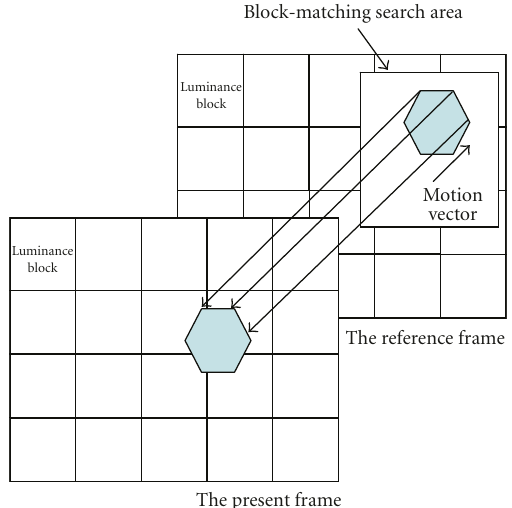
Figure 1: Block Matching Process, the two frames used to determine the motion vector of a given block.